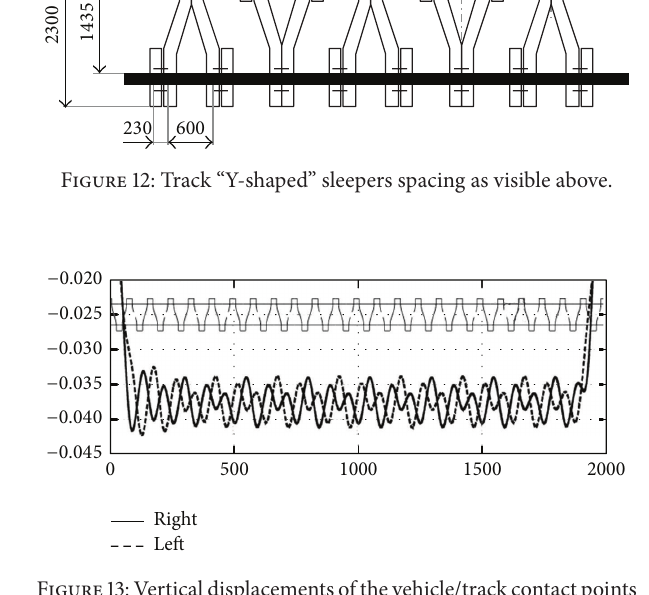
Figure 13: Vertical displacements of the vehicle/track contact points at the speed 30 m/s [11, 12].